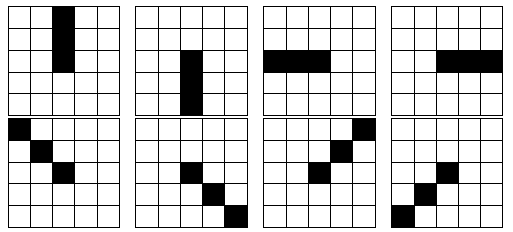
Figure 5. The filtering direction discrimination function was as Equations (9) and (10). (cid:1845) (cid:3036) was the standard deviation of all available pixel values in the i-th direction template centered on the current pixel. The filtering direction was satisfied Equations (9), which was selected the direction template with the minimum standard deviation.